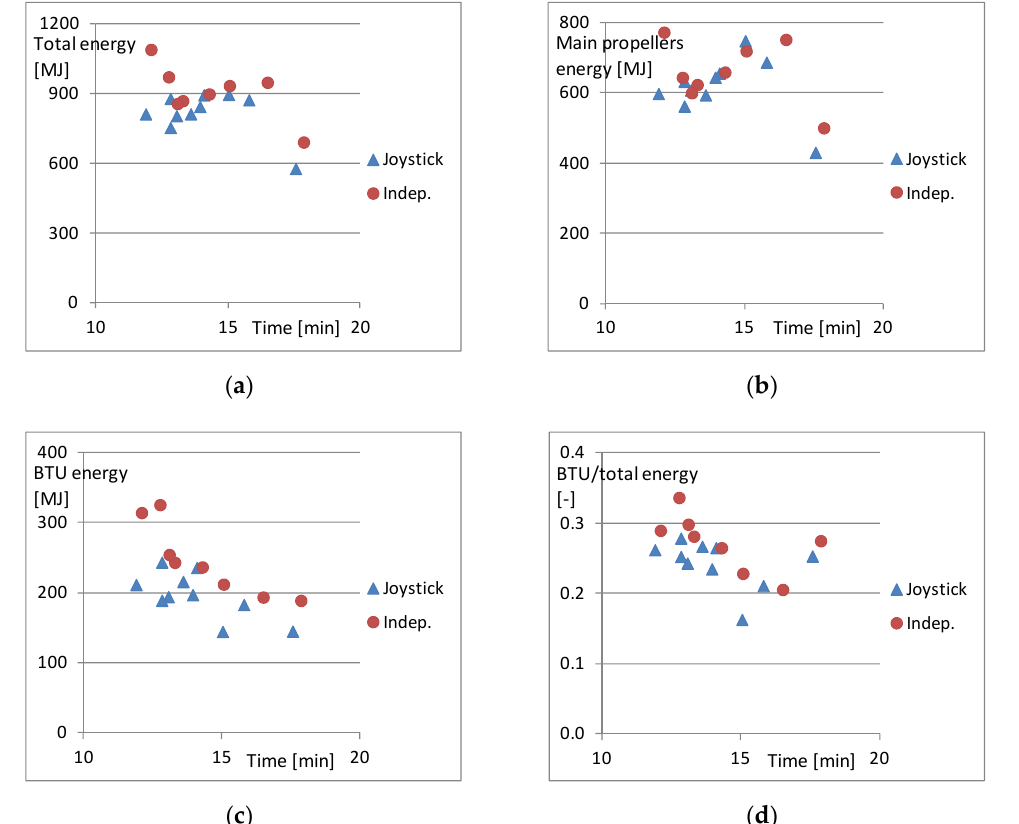
Figure 9. Energy consumption versus time of the test manoeuvre: ( a ) total energy (BTU+main propellers) (MJ); ( b ) energy of main propellers (MJ); ( c ) energy of BTU only (MJ); ( d ) ratio of BTU to total energy (–).